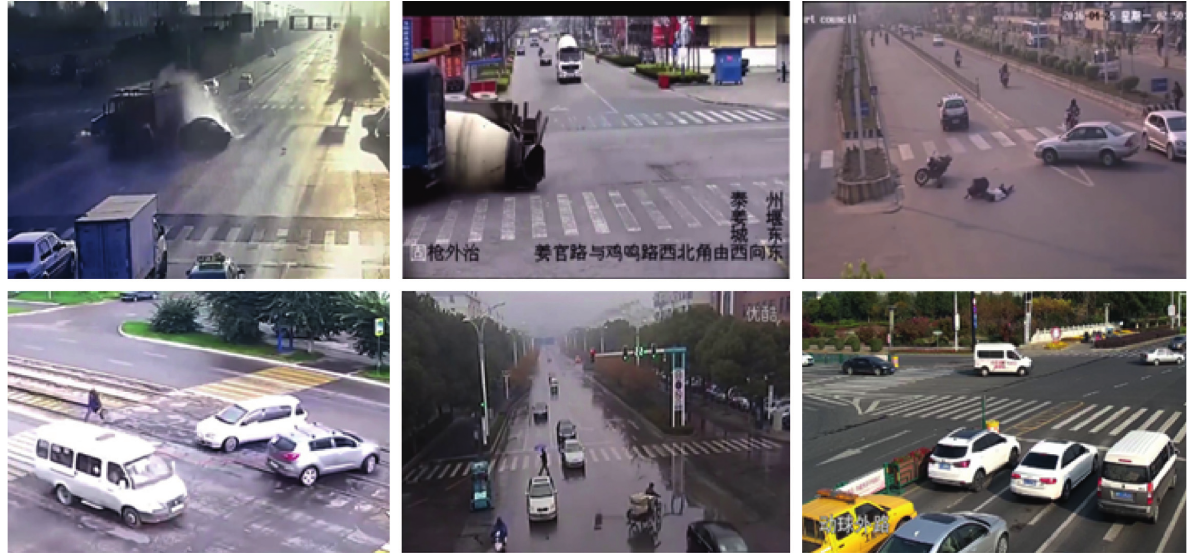
Figure 7: Traffic image dataset. Table 1: Performance of crash appearance feature extractors.